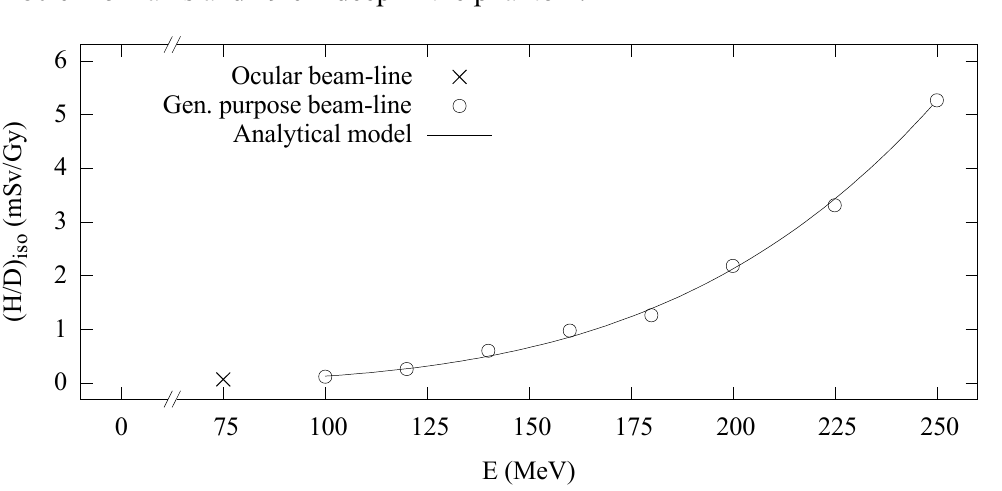
Figure 3. (𝐻/𝐷) values versus proton beam energy, E. Ocular beamline value ( ×) was 𝑖𝑠𝑜 measured in-air. General-purpose beamline values (circles) were obtained from Monte Carlo simulations. Analytical model (line) values were calculated using Equation (2).